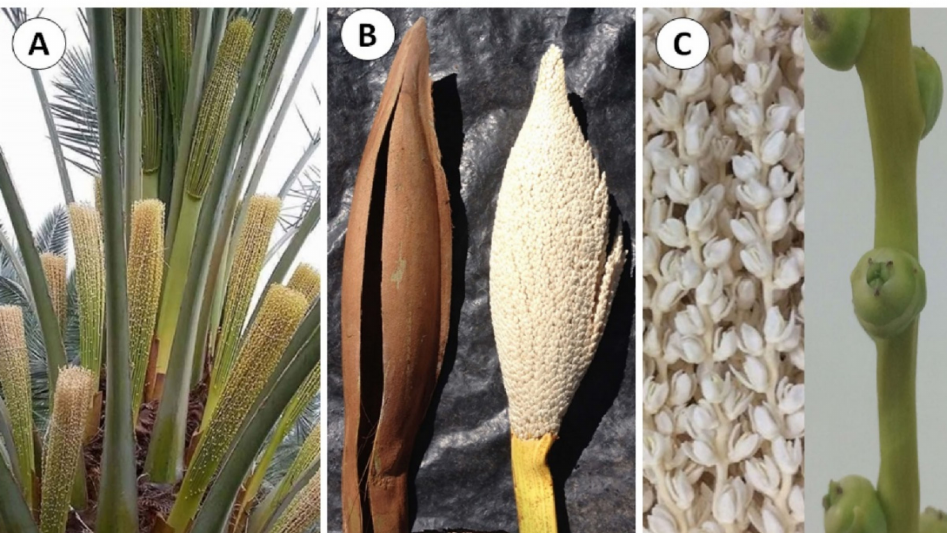
Figure 1. Male and female inflorescences on the date palm. ( A ) Two groups of female inflorescences with different stages of development. The inflorescences at the bottom are ready for pollination. ( B ) Male inflorescence (right) outside its spathe (left), in the drying process prior to the extraction of pollen. ( C ) Male strands (left) and a single female strand (right). Source: Images A (Adapted from [16]). B, C (Photos by Ricardo Salom ó